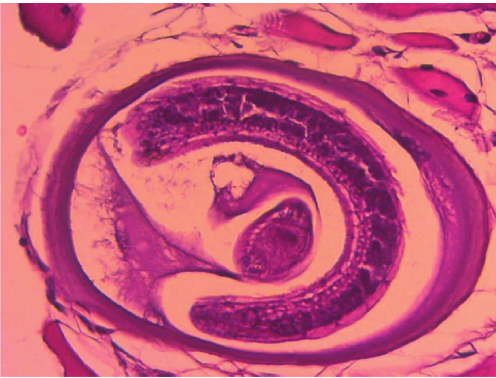
Figure 3: Cysts of Trichinella spiralis (high-power